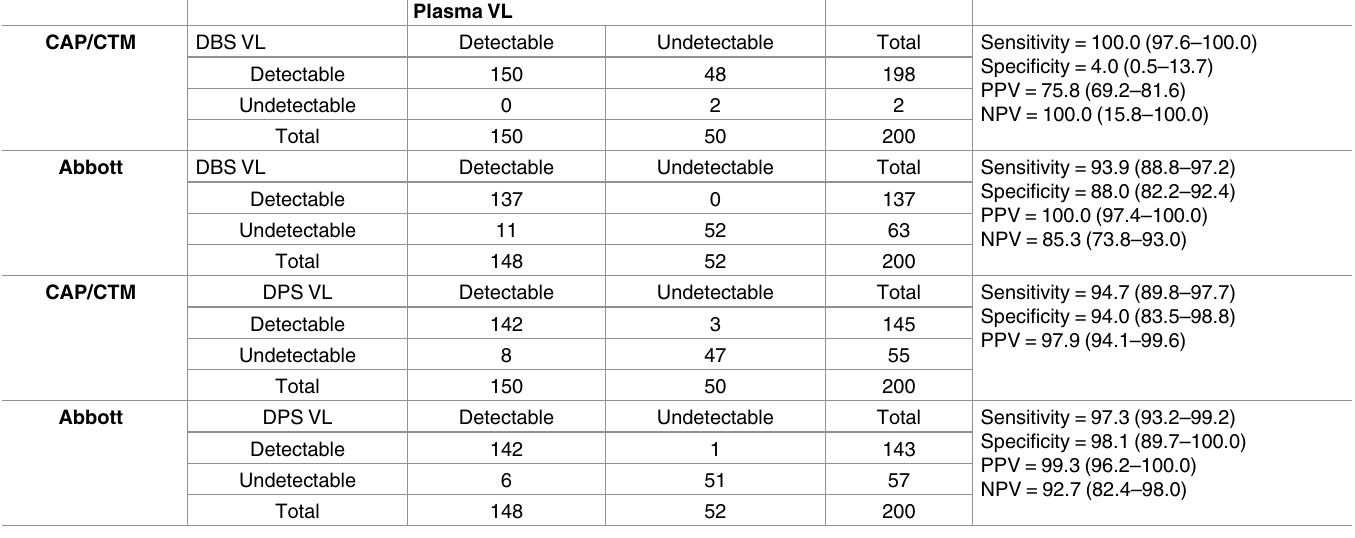
Table 3. Sensitivity, specificity, positive predictive value (PPV), and negative predictive value (NPV) (95% confidence intervals) of dried blood spot (DBS) and dried plasma spot (DPS) compared with paired plasma specimen VL, patient support centers, Nyanza, Kenya. (November 2012 to February